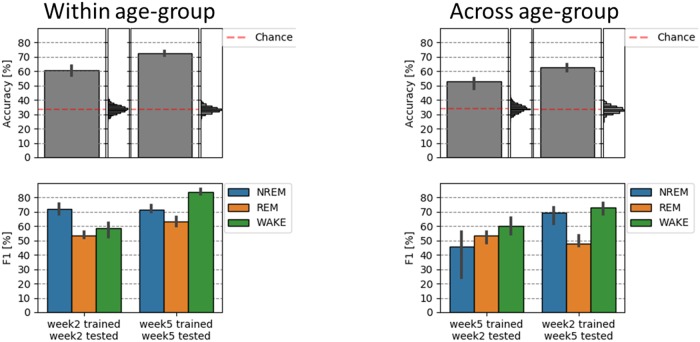
Classification of sleep states in the week-2 and week-5 old newborn (left panel) and its generalization across age (right panel).Sleep in older (5 week old) babies can be classified more accurately as compared to 2 weeks (left panel). Right panel shows that the “generalization” or classification across age-groups leads to lower classification accuracy specifically for detecting stage NREM (week-5 training, week-2 test), but also stage REM (week-2 training, week-5 test). Vertical histograms represent the null distribution, with the empirically estimated chance levels in both cases being close to 33% (red dashed line). 95% confidence-intervals (for both accuracy and F1 scores) are displayed on the basis of bootstrap analysis.